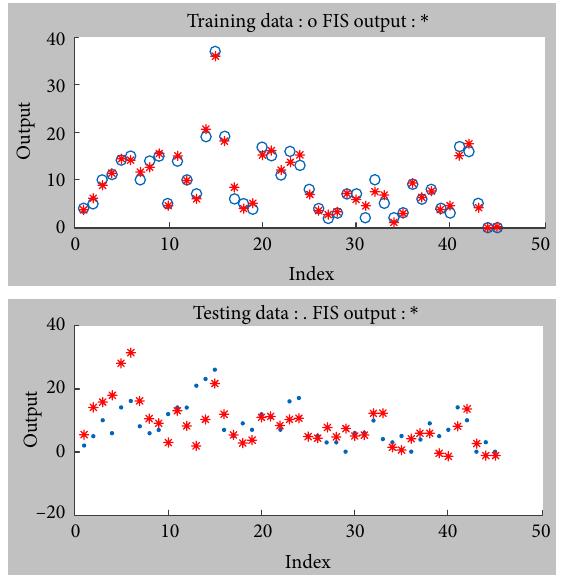
Figure 5: Training data and testing data of ANFIS